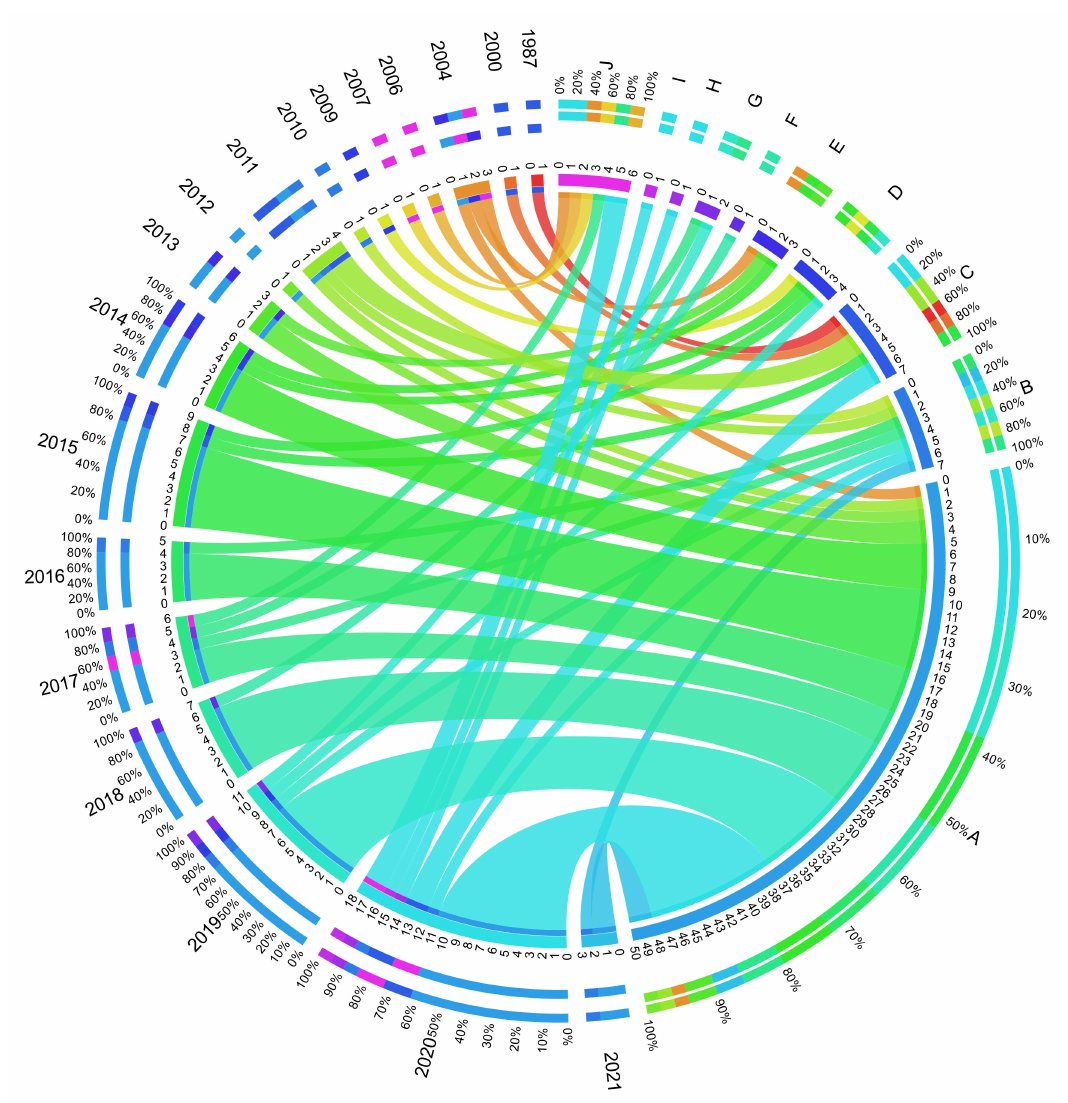
Figure 3. Representation of the included records, by research methodology and year of